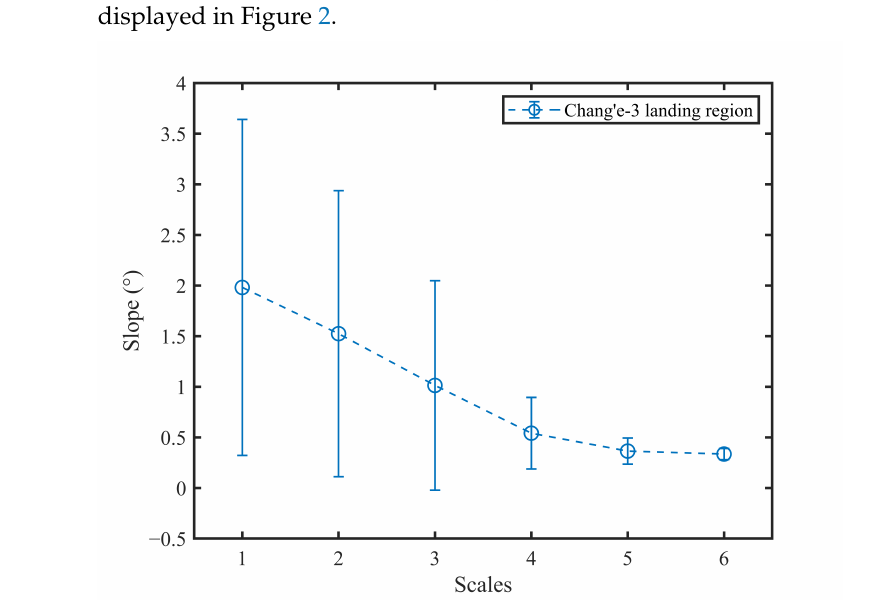
Figure 2. The topographic slope’s averages and standard deviations at six different scales. The labels “1” to “6” of the horizontal axis correspond to the subfigures (a) to (f) of Figure